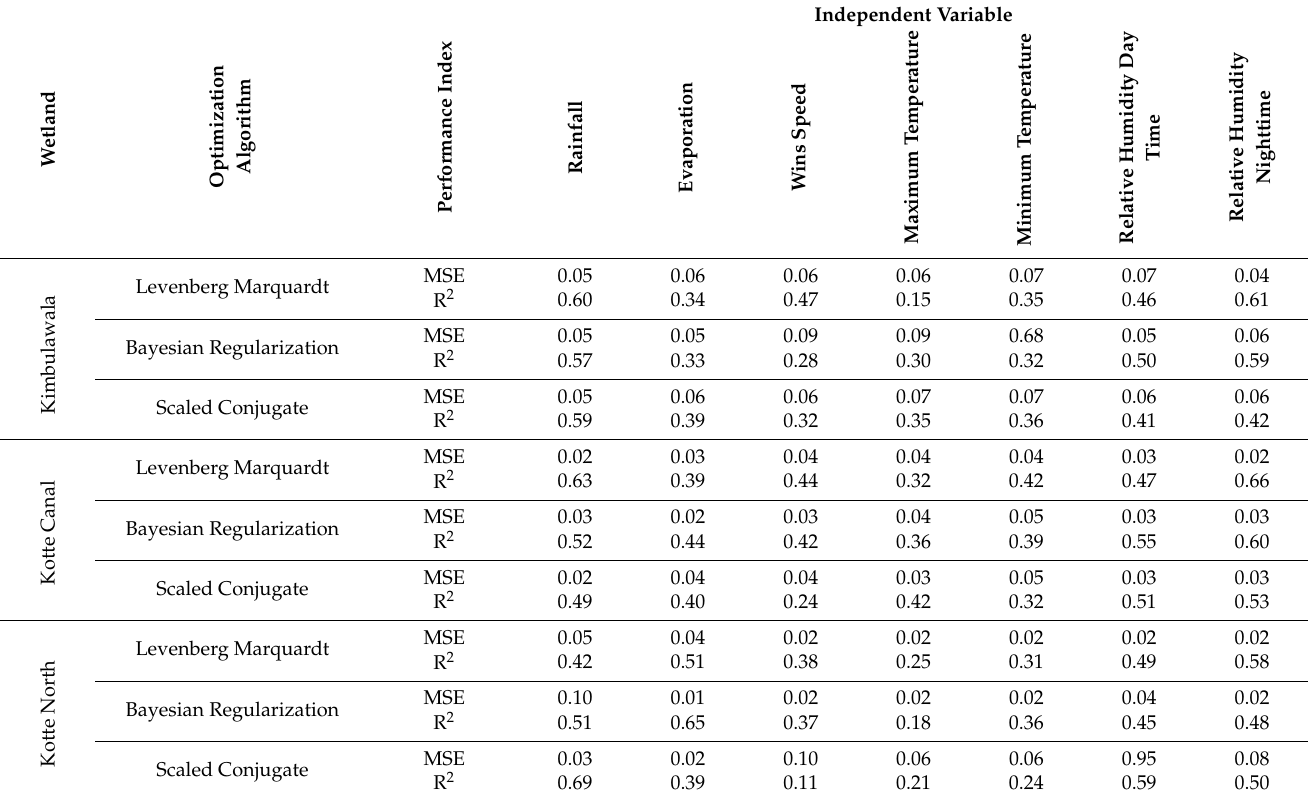
Table 1. Sensitivity (R 2 and MSE values) of independent variable in predicting water